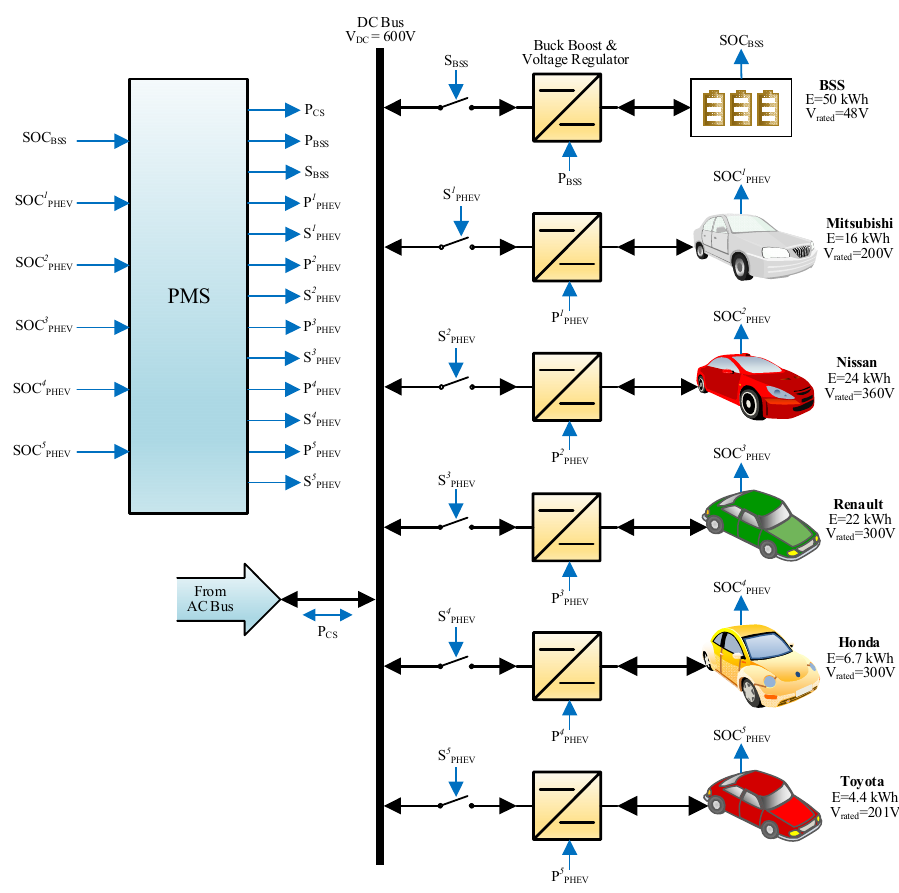
Figure 2. Structure of electric charging station.